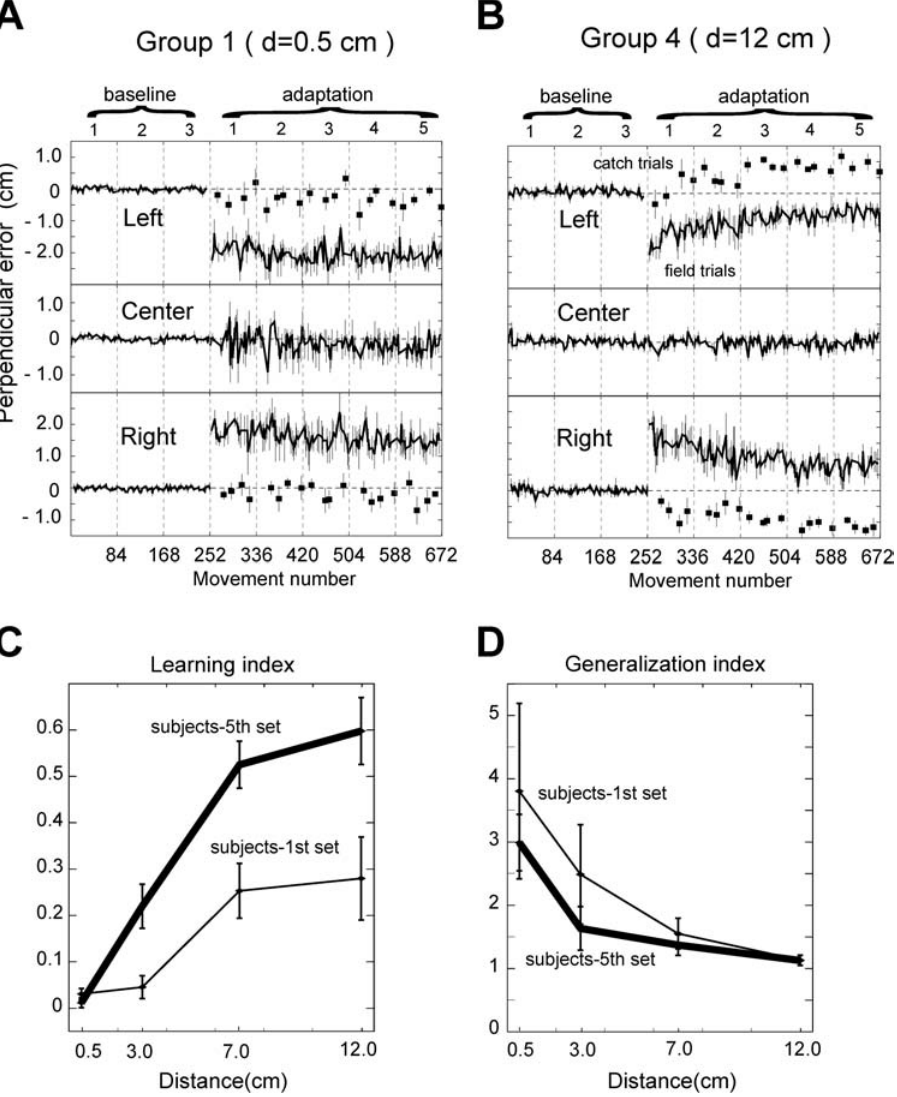
Figure 2. Movement Errors and Learning Performance as a Function of the Separation Distance (A) PE averaged across six subjects of Group 1 ( d ¼ 0.5 cm). Squares indicate catch trials. Error bars show SEM. The average SEM at the center is 1.3 mm in the baseline sets and 6.6 mm in the adaptation sets for Group 1. The average SEM is 2.1 mm in the baseline sets and 2.4 mm in the adaptation sets for Group 4. (B) Errors were averaged across six subjects of Group 4 ( d ¼ 12 cm). (C) Average learning index (Equation 1) across groups. Learning index is plotted against the separation distance between movements. Thin lines show the first adaptation set and thick lines show the last adaptation set. n ¼ 6 for each distance. Error bars show SEM. (D) Generalization index (Equation 2) against spatial distance between movements. DOI: 10.1371/journal.pbio.0000025.g002